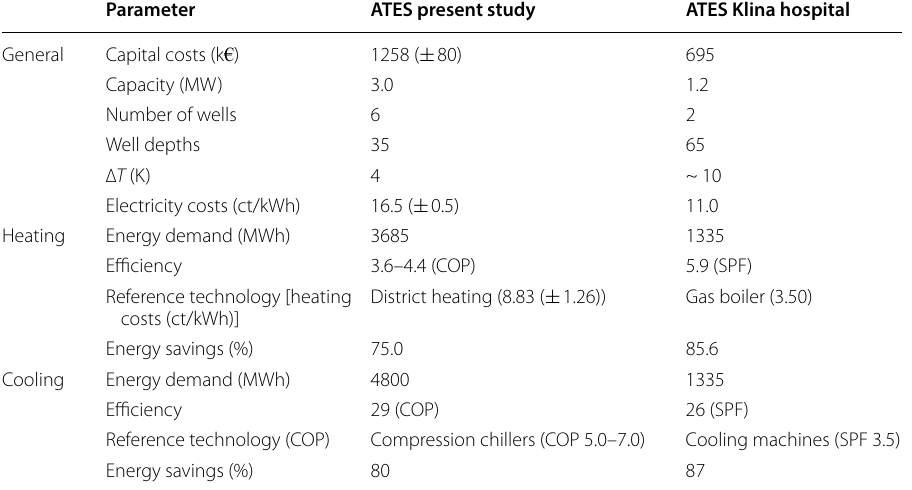
Table 10 Comparison of the most important parameters defining the ATES system of the Klina hospital in Belgium and the ATES system of the present